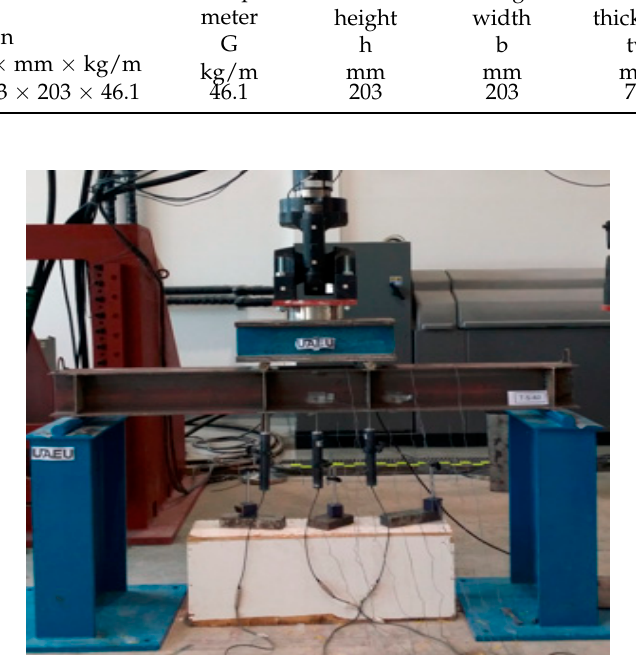
Figure 2. Beam test setup.